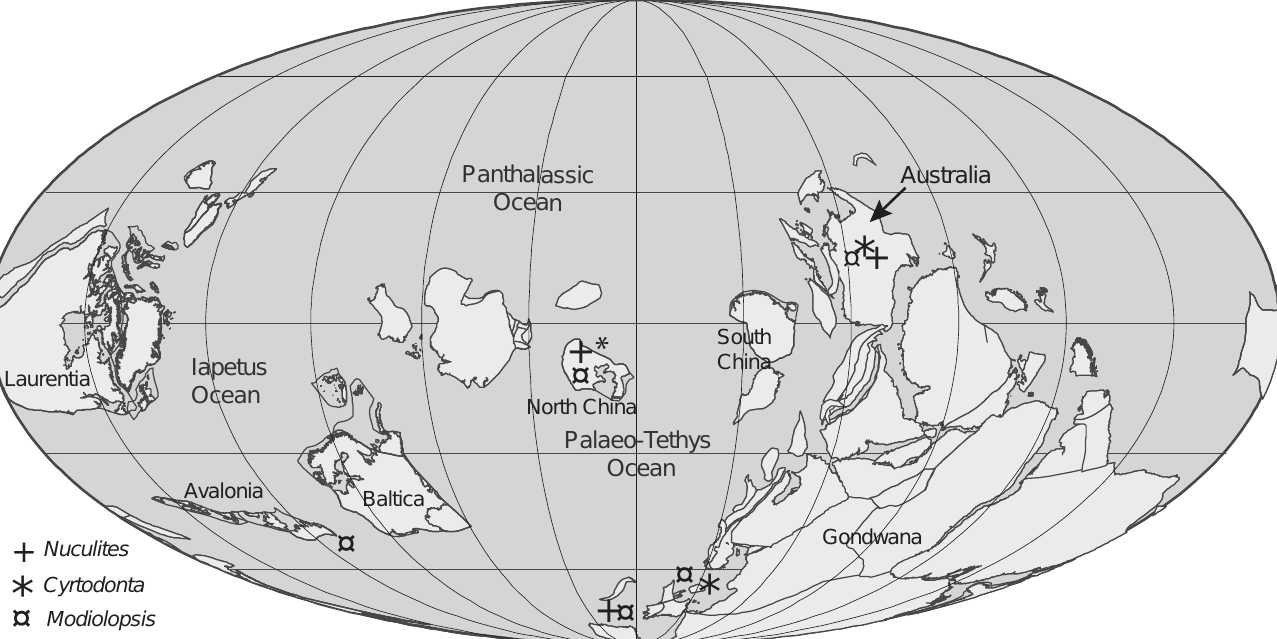
Fig. 7. Distribution of the cosmopolitan genera Modiolopsis , Cyrtodonta , and Nuculites found in the Stairway Sandstone and coeval strata elsewhere during the Middle Ordovician. Map modified from Torsvik et al . (2014).